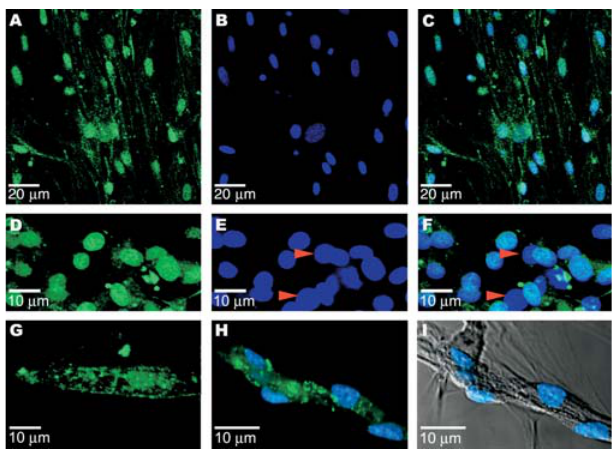
Figure 3. CPS Cells Stain Positive for Cardiac-Specific Proteins (A) GATA-4 in day 7 CPS cells. (B) Nuclear staining with DAPI. (C) Overlay of (A) and (B). (D) Nkx-2.5 is detected in the nuclei of round, day 21 beating cells (green). (E) Noncardiac cells (red arrowheads) do not show nuclear staining for Nkx-2.5. (F) Overlay of (D) and (E). (G) Beating cells, after 28 d in culture, stain positive for cardiac L- type Ca þþ channel. (H) Connexin 43 (green) in cluster of uninucleate day 21 beating cells in culture. (I) Nomarski light micrograph (differential interference contrast) of cell cluster in (H). DOI: